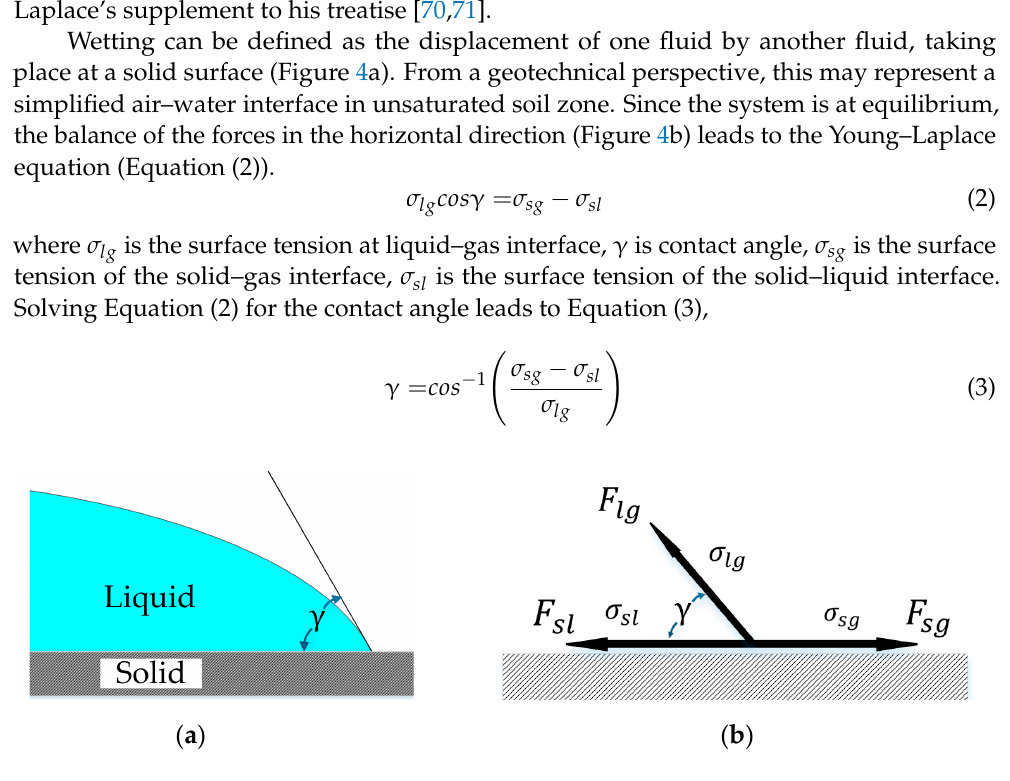
Figure 4. ( a ) Cross sectional representation of liquid/air contact with a solid; ( b ) horizontal balance of forces at the point of contact at equilibrium which yields to Young–Laplace equation, modified from [72].